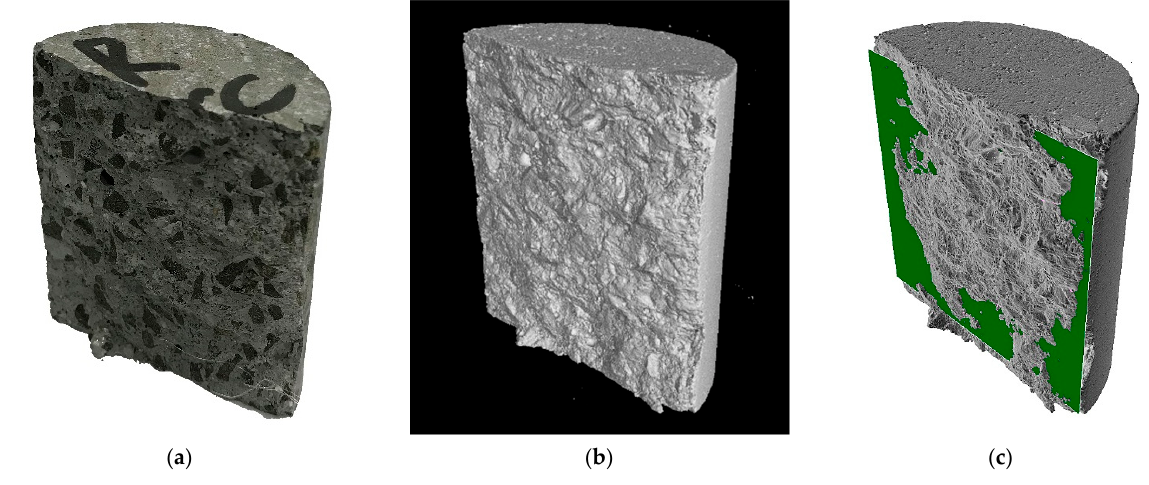
Figure 8. Tensile by splitting: ( a ) Post-test specimen; ( b ) CT-based reconstructed model; ( c ) Speci- men including nominal plane.